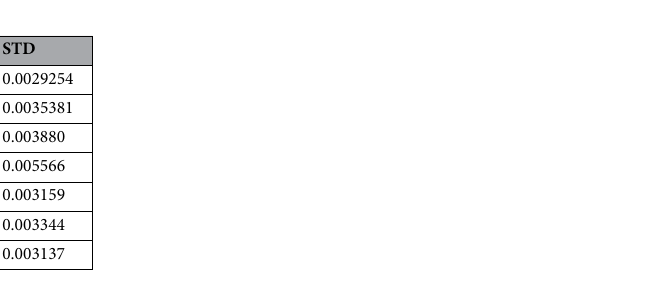
Table 9. Statistic test of methods capability for multiobjective problem of unbalanced 118-bus